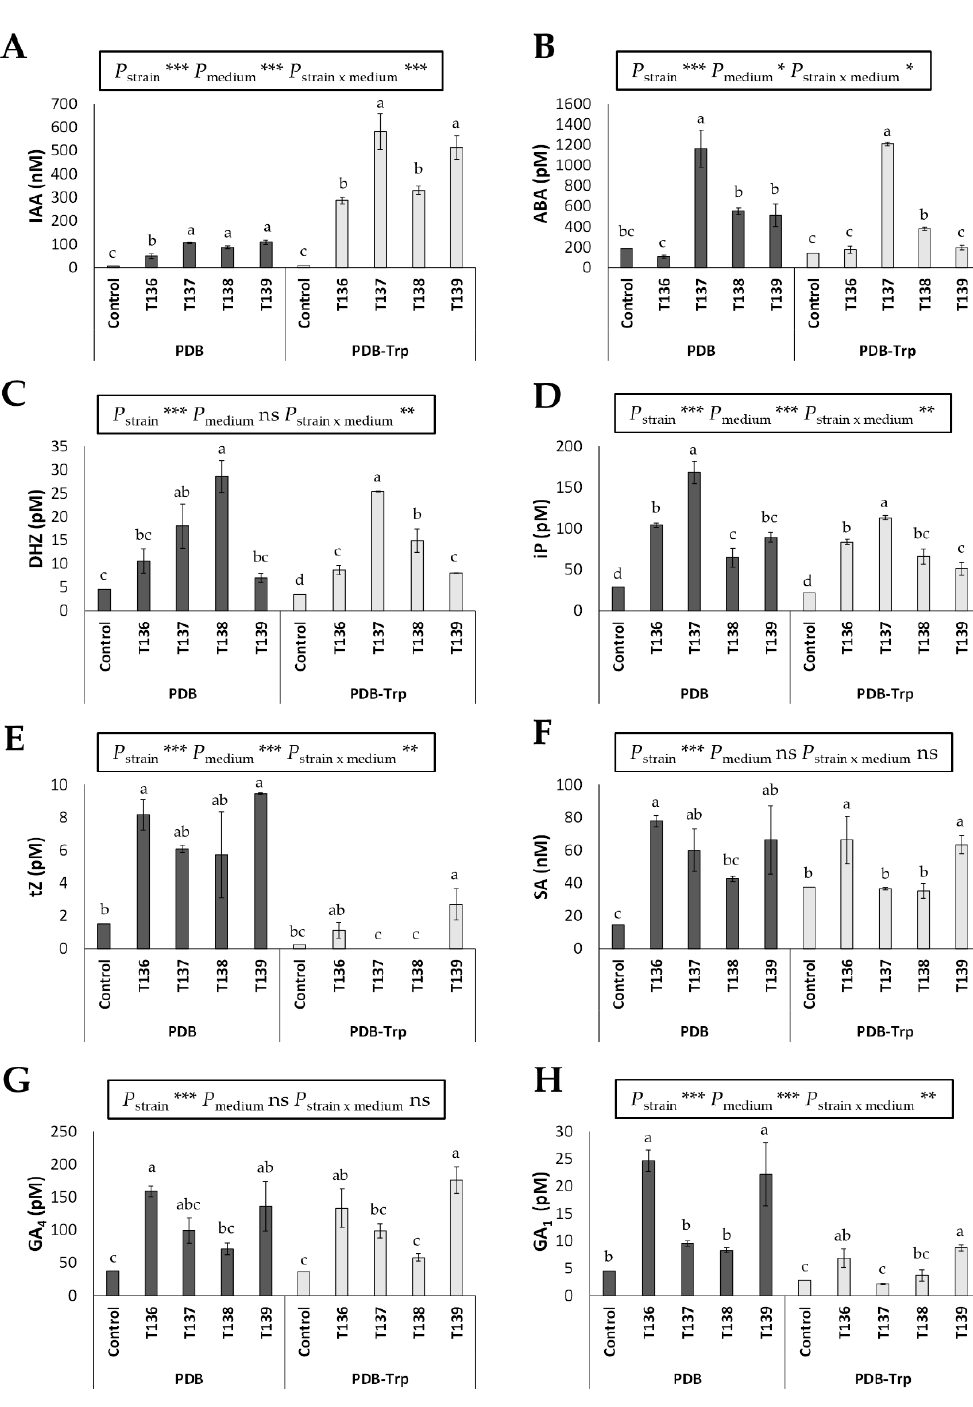
Figure 4. Phytohormone production in two day PDB and PDB-tryptophan (Trp) cultures by four Trichoderma strains ( T. harzianum T136, T. simmonsii T137, T. afroharzianum T138, and T. harzianum T139) compared to their respective PDB and PDB-Trp media controls. ( A ) Indole-3-acetic acid (IAA), ( B ) abscisic acid (ABA), ( C ) cytokinin dihydrozeatin (DHZ), ( D ) cytokinin isopentenyladenine (iP), ( E ) cytokinin trans-zeatin (tZ), ( F ) salicylic acid (SA), ( G ) gibberellin 4 (GA 4 ), and ( H ) gibberellin 1 GA1 (GA 1 ). The data were calculated from three replicates per strain and culture medium. For each phytohormone and culture medium, different letters above the bars indicate significant differences according to one-way analysis of variance (ANOVA) followed by Tukey’s test ( p < 0.05). For each phytohormone, significant effects were determined by a two-way ANOVA for Trichoderma strain, culture medium, and the combination strain per culture medium (***: p < 0.001; **: p < 0.001; *: p < 0.05; ns: no statistical differences).